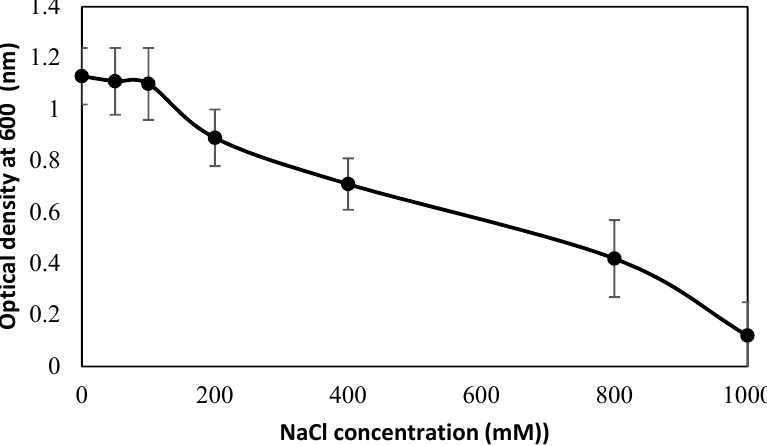
Figure 6. Growth responses of bacterial-strain PsJN observed by measuring optical density (OD) at λ 600 nm under varying salinity levels (ranging from 0 to 1000 mM NaCl solutions).